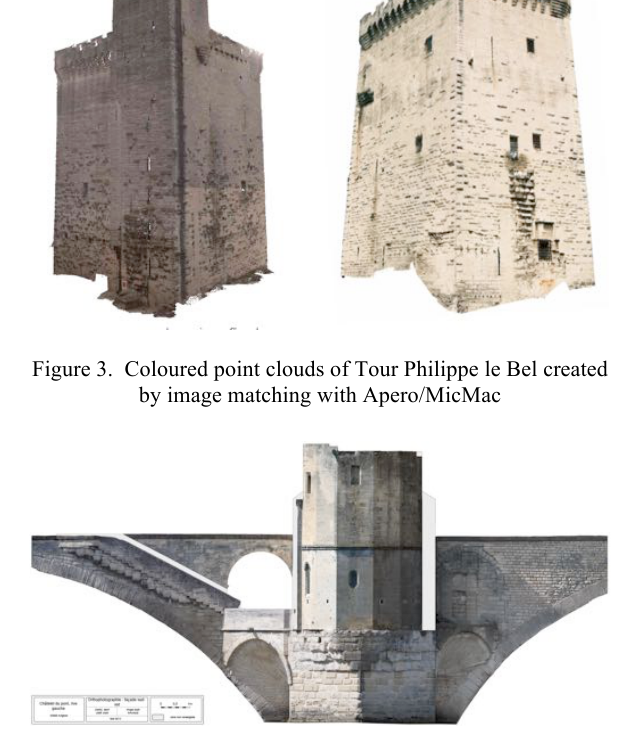
Figure 2. Overlapping of an ancient map (Carte du Rhône à Villeneuve - J-F de MONTAIGU – 1685) with the CNR survey of the piers remains in 1969